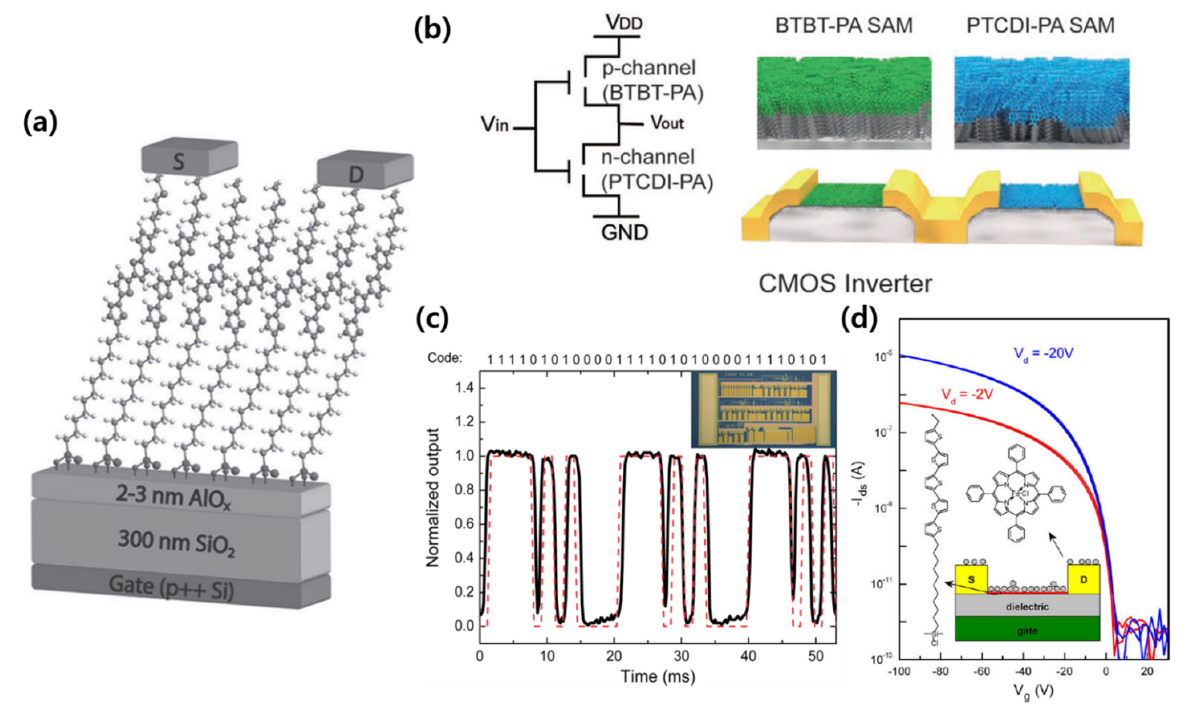
Figure 5. SAMs as semiconductor layers. ( a ) Schematic of a SAMFET based on phosphonic acid SAM (adapted from [52] with permission from John Wiley and Sons). ( b ) Schematic and illustration of a SAMFET-based CMOS inverter (adapted from [53] with permission from John Wiley and Sons). ( c ) The output of a 4-bit code generator incorporating over 100 SAMFETs. The red dotted line indicates the preprogrammed code (adapted from [54] with permission from the American Chemical Society). ( d ) Typical SAMFET transfer characteristic and the schematics of a SAM-based gas sensor (adapted from [55] with permission from Elsevier).